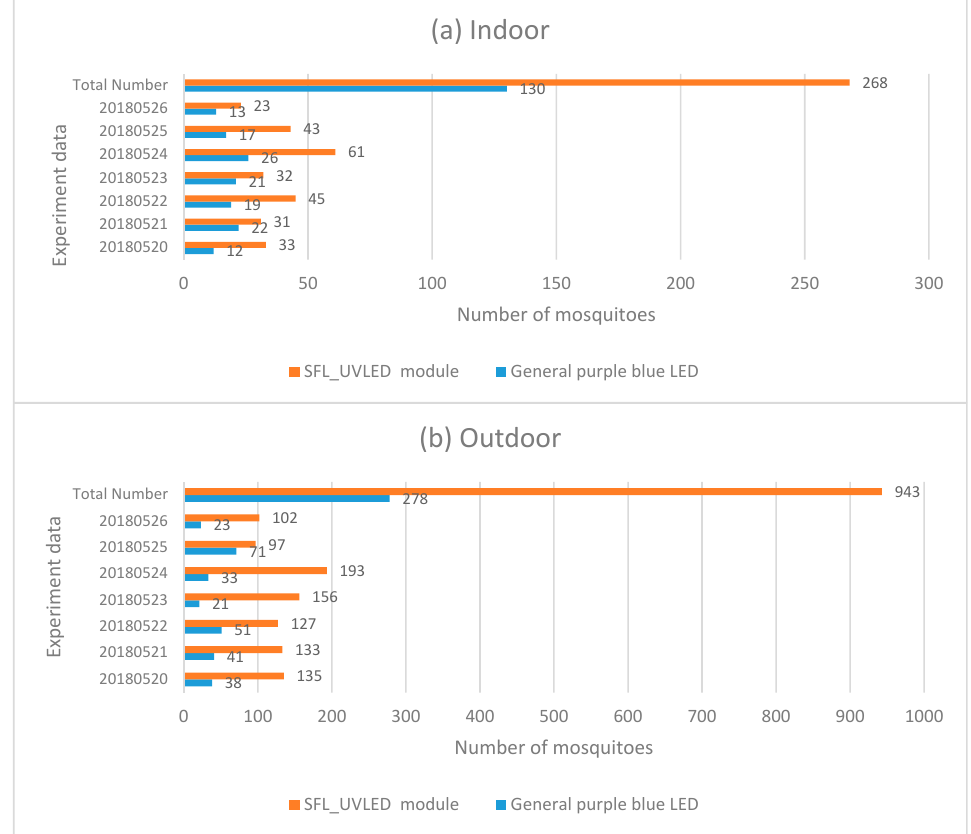
Figure 10. Comparison of ( a ) indoor and ( b ) outdoor test results of purple blue LED mosquito trapper and UV LED mosquito trapper with 150° SFL module.